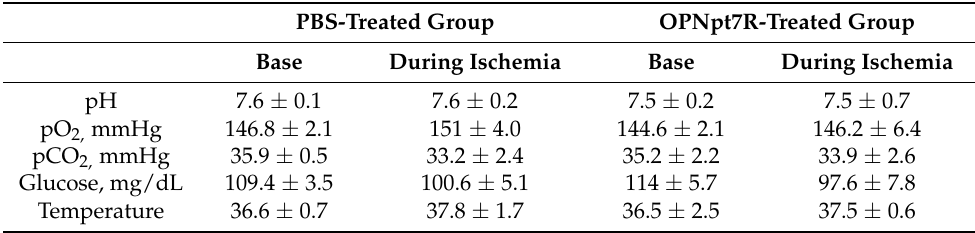
Table 1. Physiological